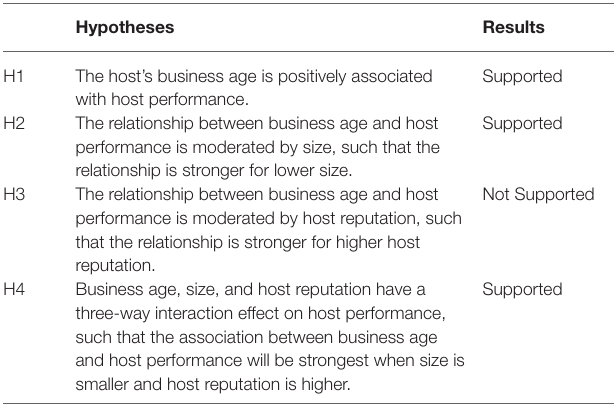
TABLE 4 | Test of